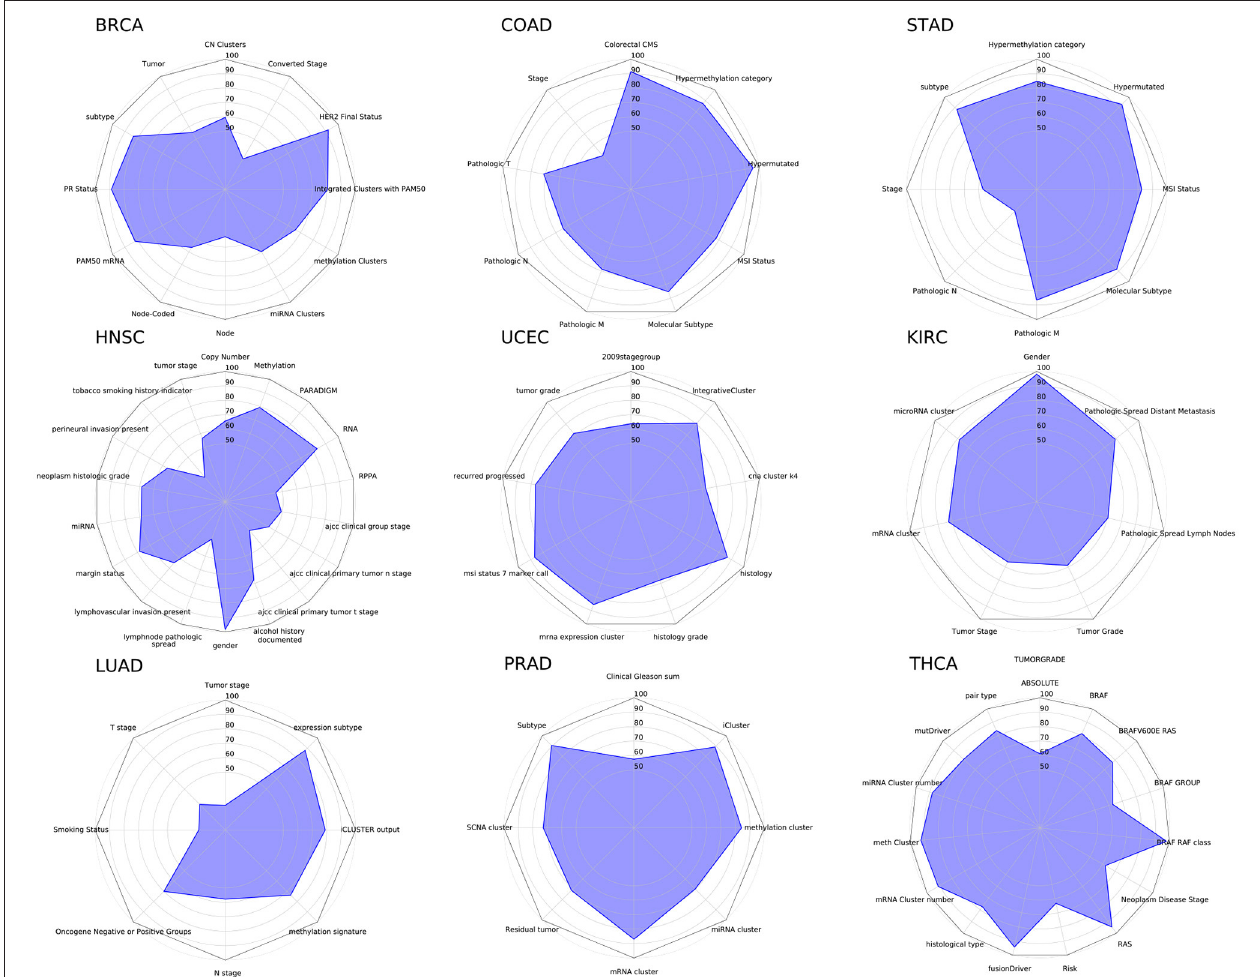
FIGURE 10 | The radar chart showing classification results of nine cancers and their clinical attributes. Luminal B subtypes are relatively more mixed ( Figure 11A